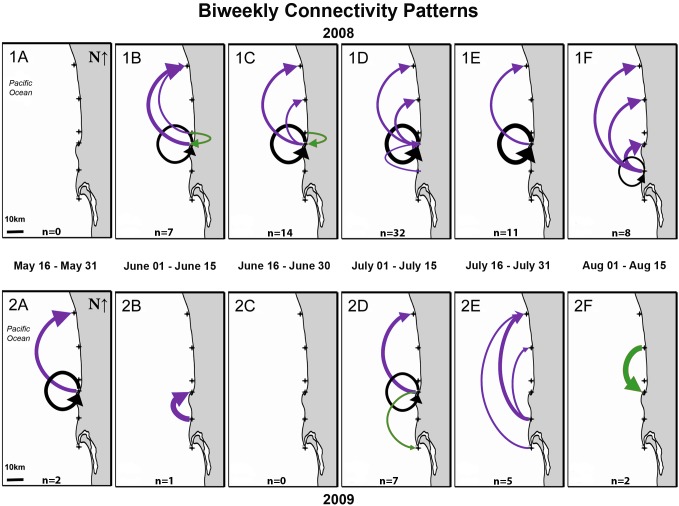
Bi-weekly connectivity patterns in 2008 (Fig. 4-1A-1F) and 2009 (Fig. 4-2A-2F).Dates indicate the two-week bin in which an embryonic fish was developing on a benthic nest (i.e. acquiring its natal elemental fingerprint). Grey region is land and white region is ocean. Arrows indicate predicted larval dispersal trajectories from natal origin to capture location of post-settlement YOY. Purple arrows indicate northward dispersal, green arrows indicate southward dispersal, and black arrows indicate self-recruitment. Thickness of arrows is proportional to the number of individuals dispersing among reefs. Numbers of YOY (n) dispersing among reefs are provided at the bottom of each sub-panel. For example, in Figure 4-1B (June 01, 2008–June 15, 2008) the connectivity patterns of 7 post-settlement YOY were recreated. Crosses indicate location of primary study sites.